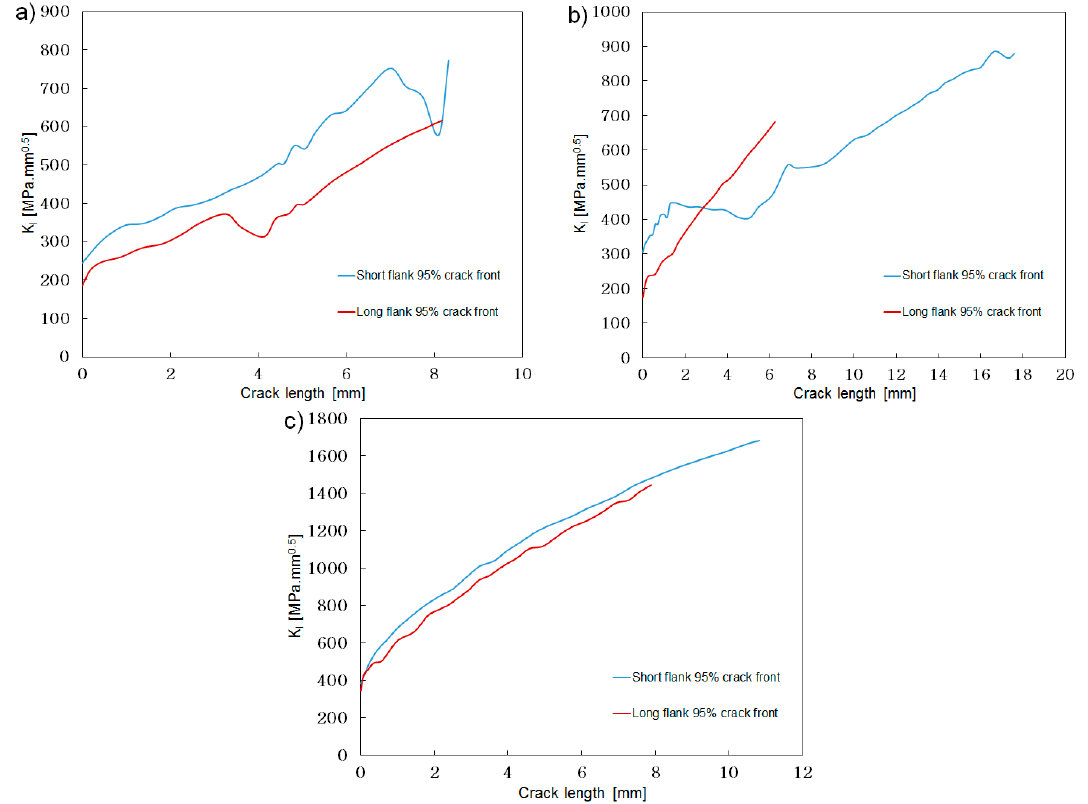
Figure 24. Short vs. long flank for all the flank angle design options: ( a ) 30°; ( b ) 45°; ( c ) 60°.